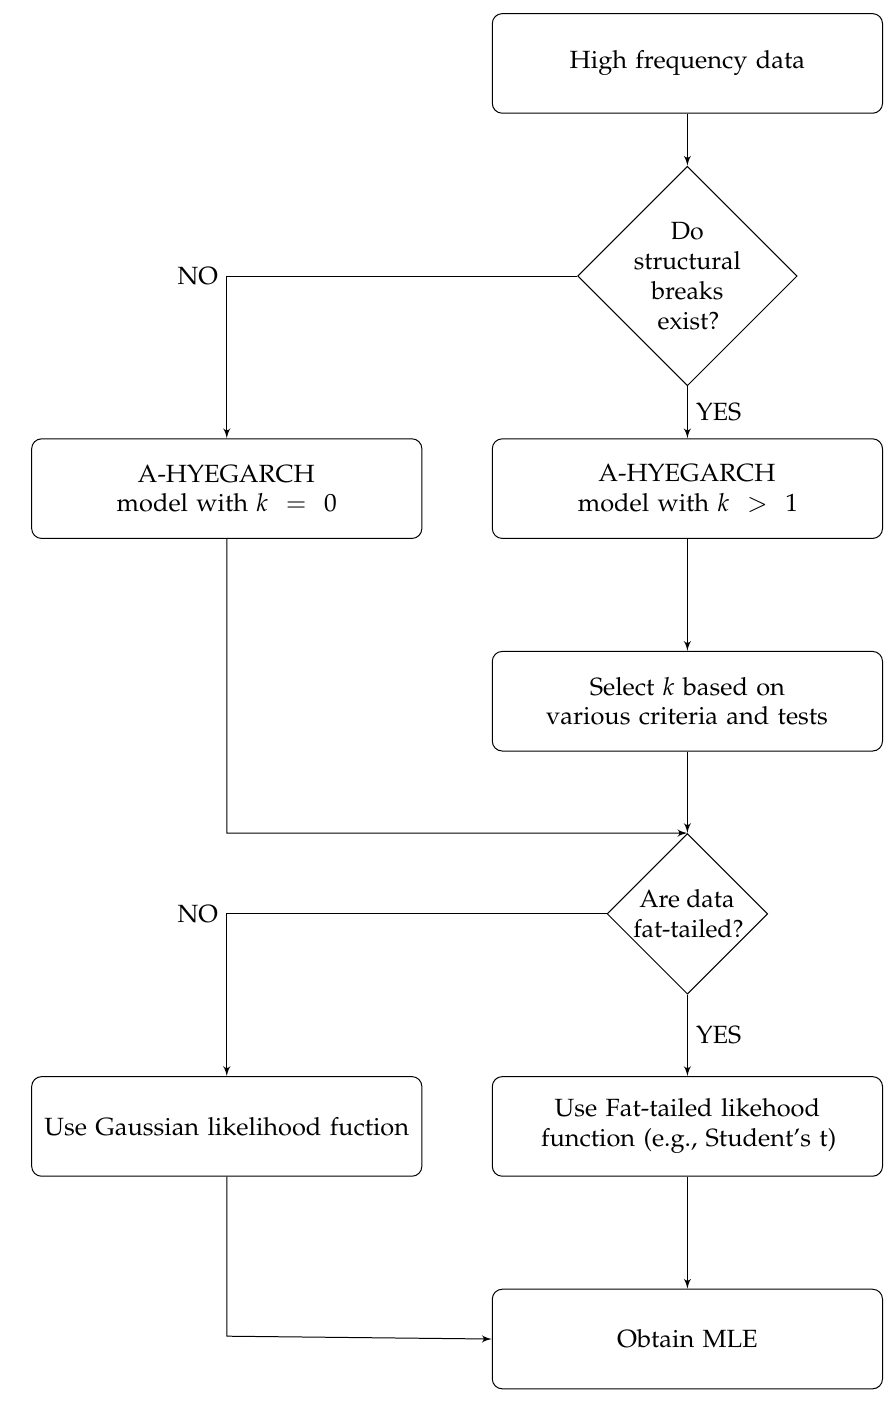
Figure 5. Flowchart of the A-HYEGARCH model fitting